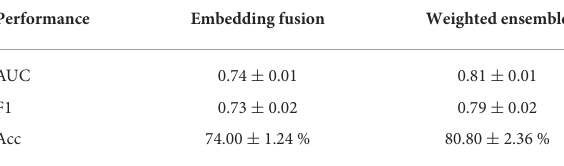
TABLE 4 Downstream task performance for embedding fusion optimization for SSML-A MLP instead of weighted ensemble. Performance Embedding